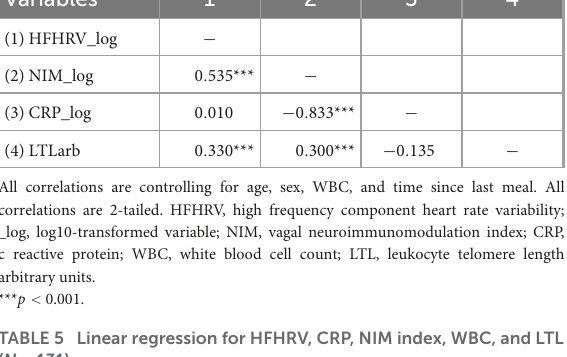
TABLE 5 Linear regression for HFHRV, CRP, NIM index, WBC, and LTL ( N = 131). Predictor Dependent variable